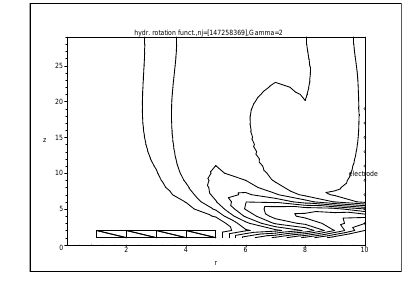
hydr. stream funct.,nj=[531642789],Gamma=7,Te=0